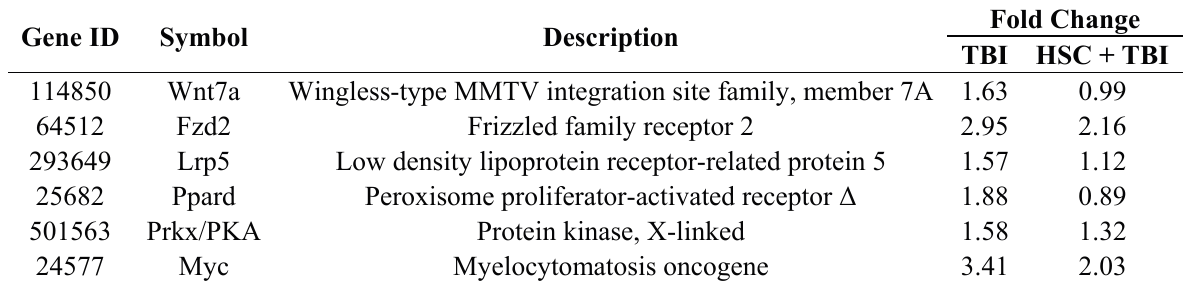
Table 5. The six genes that were involved in the Wnt signaling